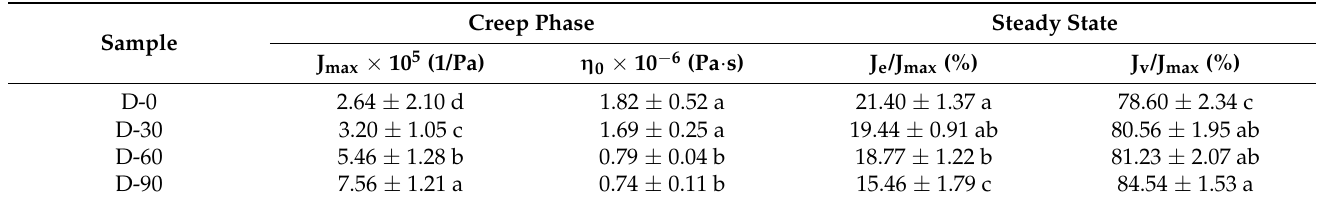
Table 4. Effect of proofing on the deformation resistance and recovery capacities of CS–HPMC gluten-free